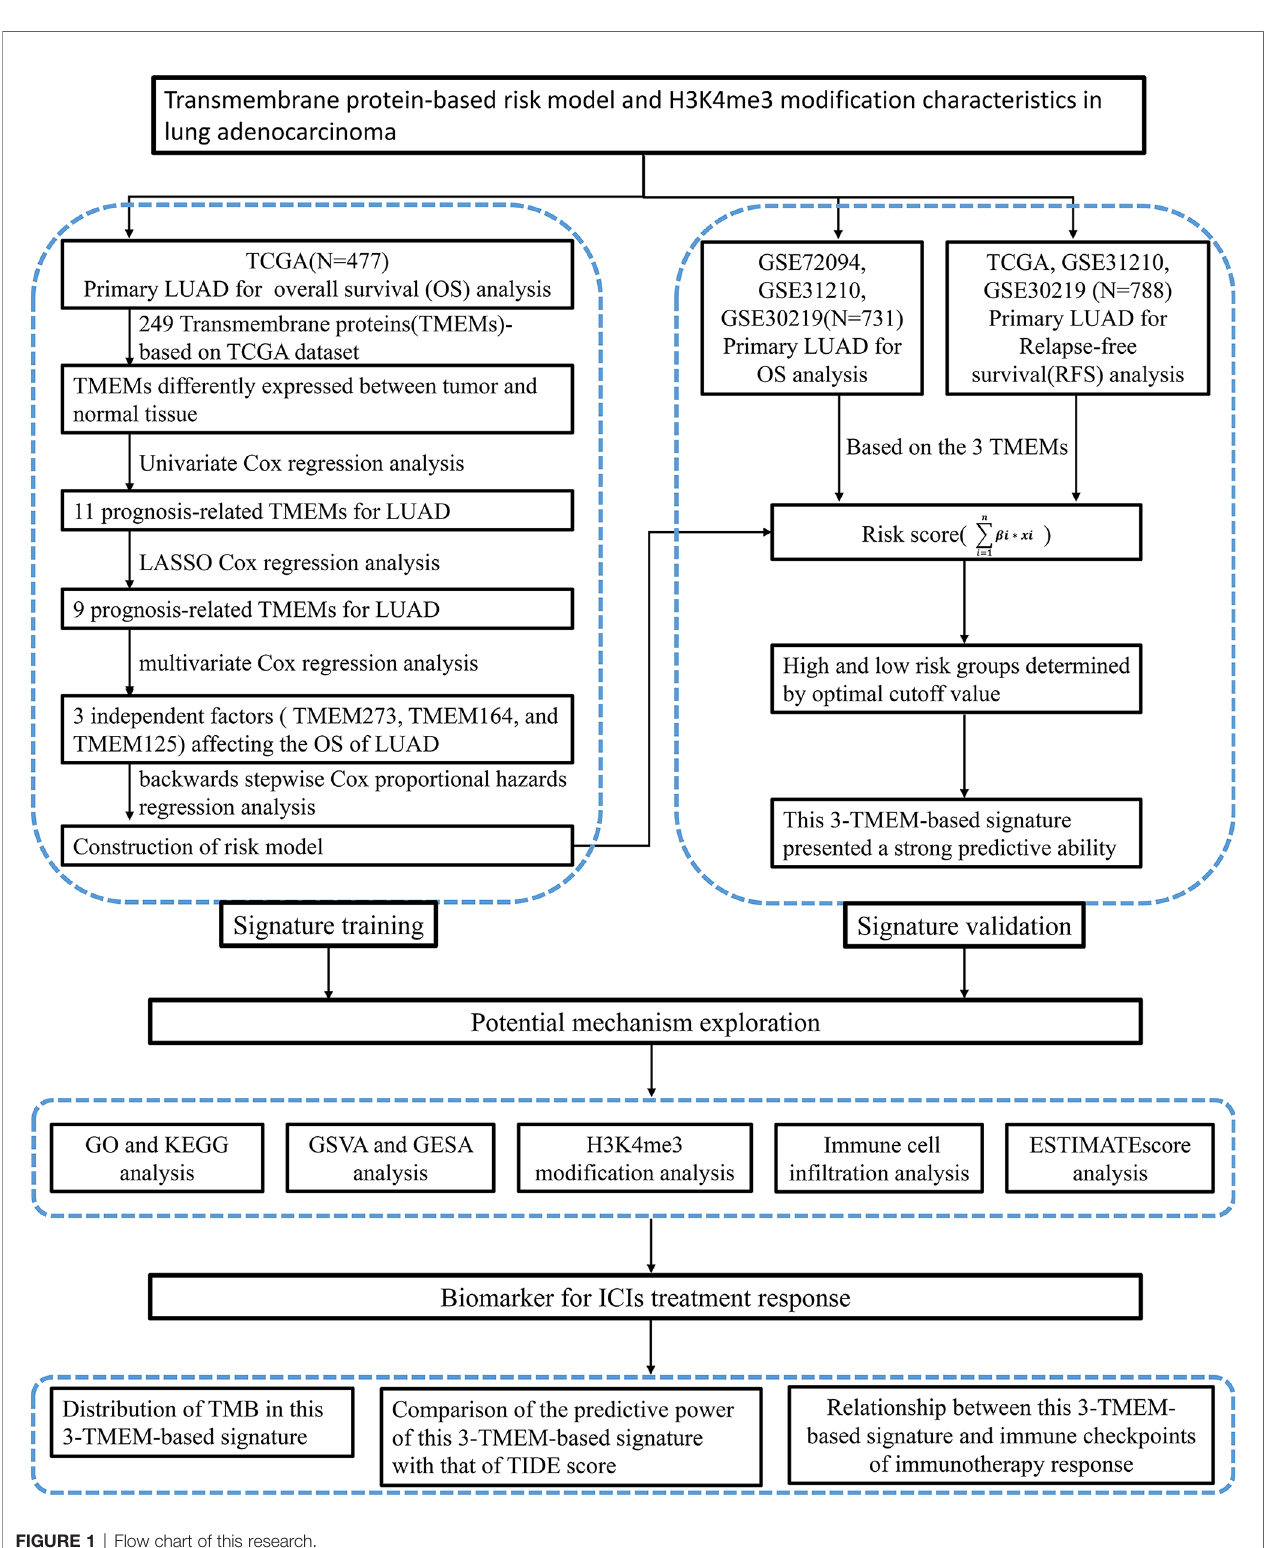
FIGURE 1 | Flow chart of this